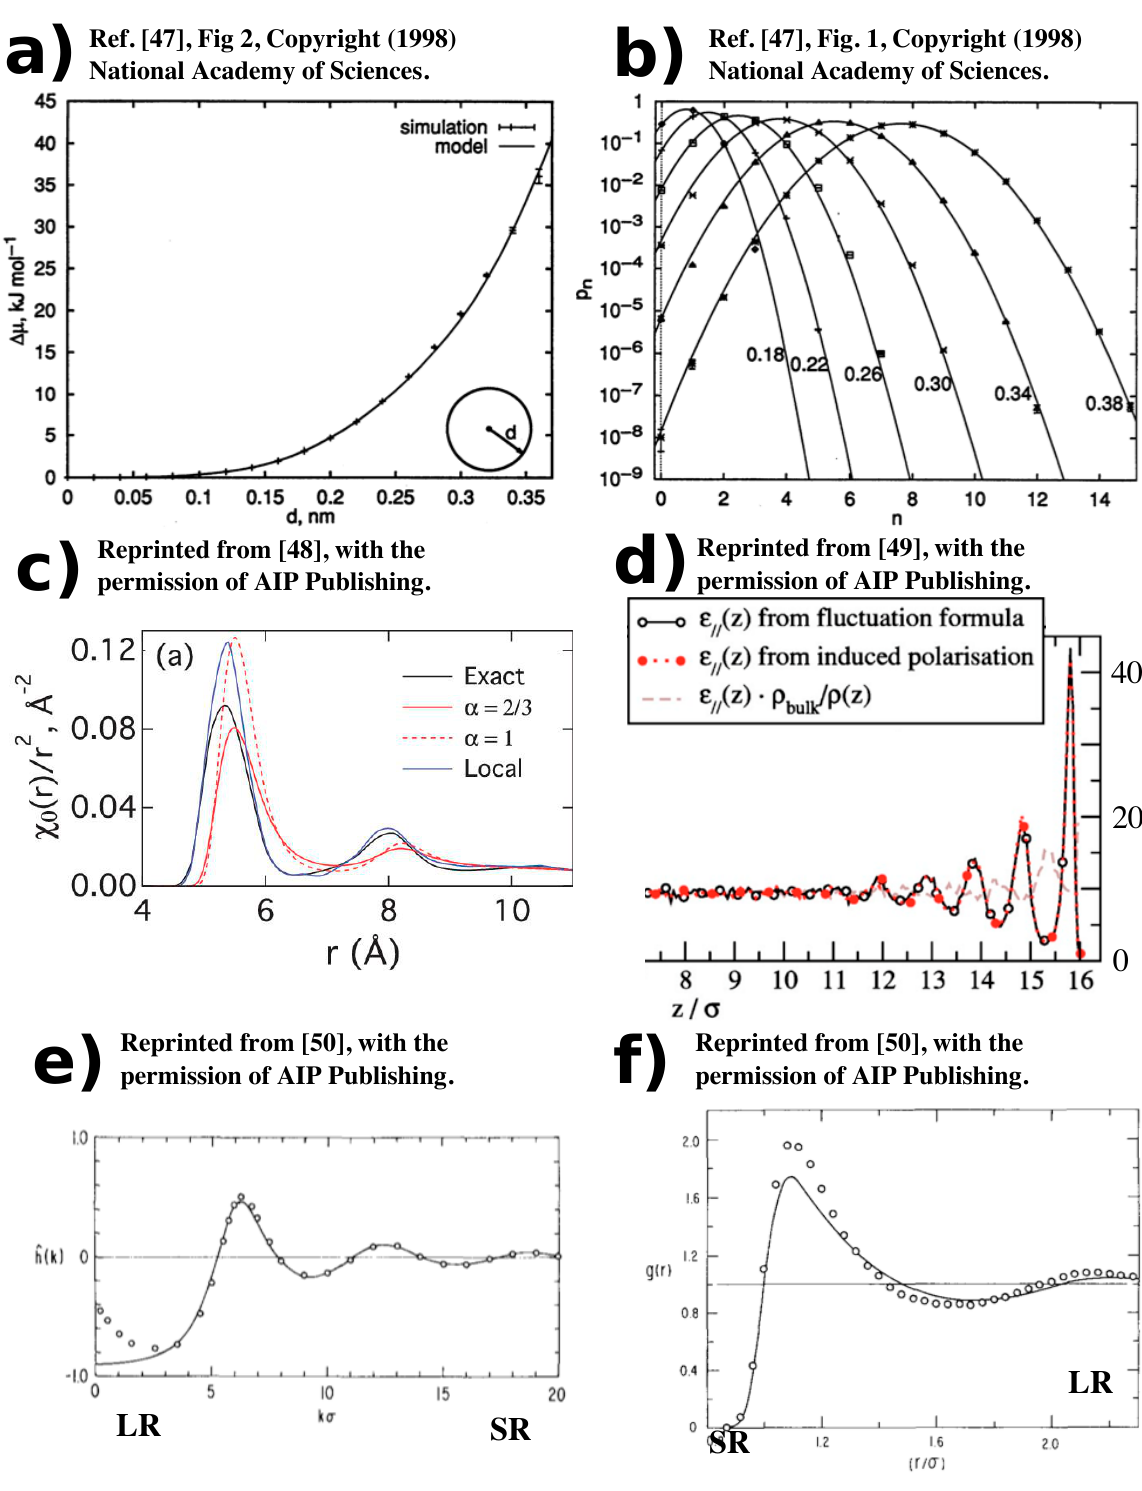
Figure 3. Short- and long-range theories of solvent dipole and electrolyte structure. (a) and (b) show free energies and number occupancy distribution for spherical cavities in water. 47 (c) shows the dielectric response in a spherical geometry 48 and (d) shows the dielectric permit- tivity computed in a slab geometry. 49 (e) and (f) show the correlation function of a supercritical Lennard-Jones fluid near n = 0 . 52 /σ 3 , T = 1 . 34 ε /k B .